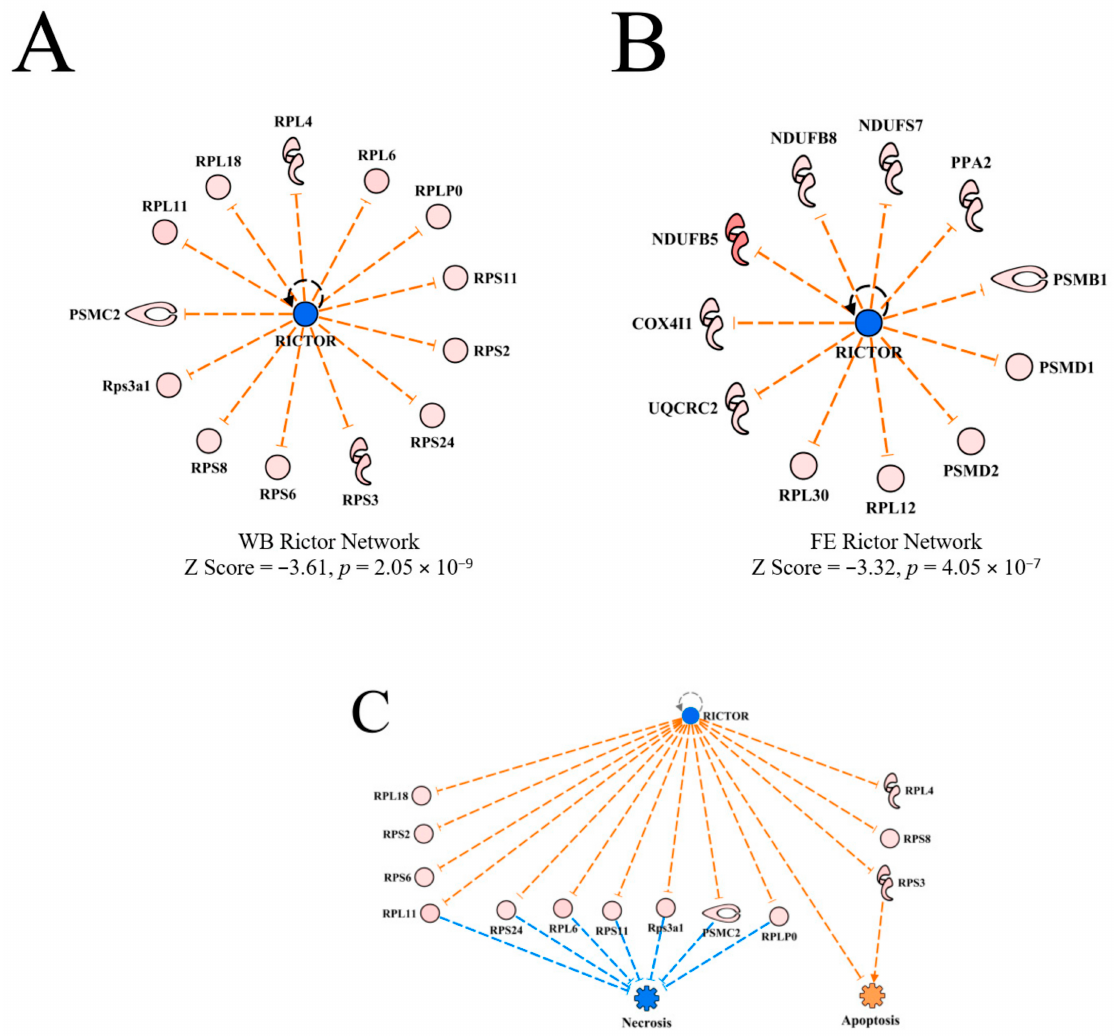
Figure 9. The upstream regulatory network for RICTOR in wooden breast (WB) myopathy ( A ) and for feed efficiency (FE) proteomics ( B ). All downstream proteins were up-regulated in both datasets, but there were no common differentially expressed proteins. The regulatory network for RICTOR linking downstream molecules to the predicted inhibition of necrosis and slight activation of apoptosis in WB myopathy ( C ). For ( A , C ), protein abbreviations are defined and differential expression of proteins in WB myopathy are provided in Supplementary Table S1. Proteins in ( B ) are as follows: COX4I1 (cytochrome oxidase subunit IV isoform 1), NDUFB5, B8, S7 (NADH dehydrogenase (ubiquinone) Complex I assembly factor 5, factor 8, subunit 7), PPA2 (pyrophosphate (inorganic) 2, PSMB1, D1, D2 (proteosome 26S subunit, non-ATPase beta type-1) PSMD1, PSMD2 (proteosome 26S subunit, non-ATPase, 1 & non-ATPase 2), RPL12, RPL30 (ribosomal protein L12 & L30), UQCRC2 (ubiquinol-cytochrome c-reductase core protein